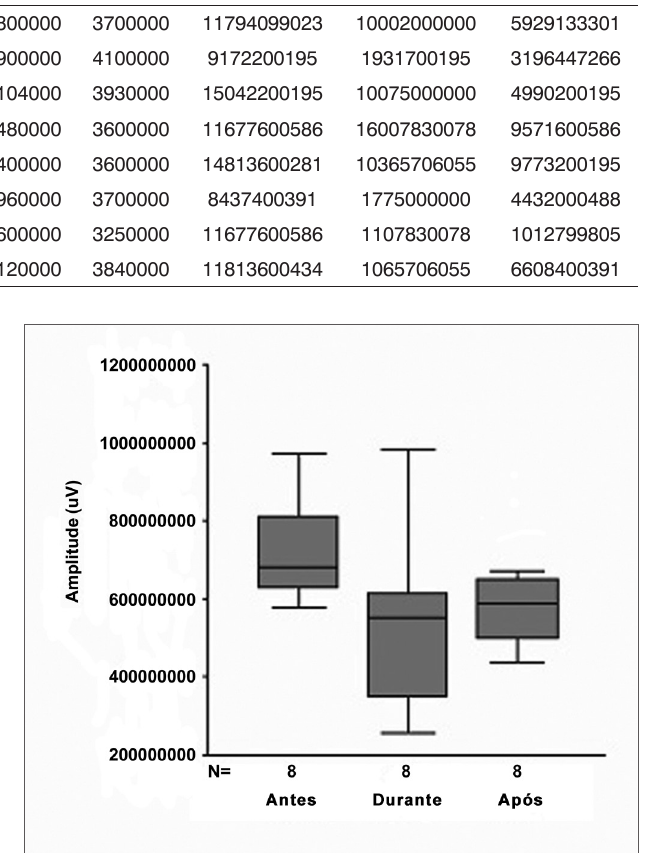
Figura 4. Gráfico box plot da amplitude nos três momentos experimentais.